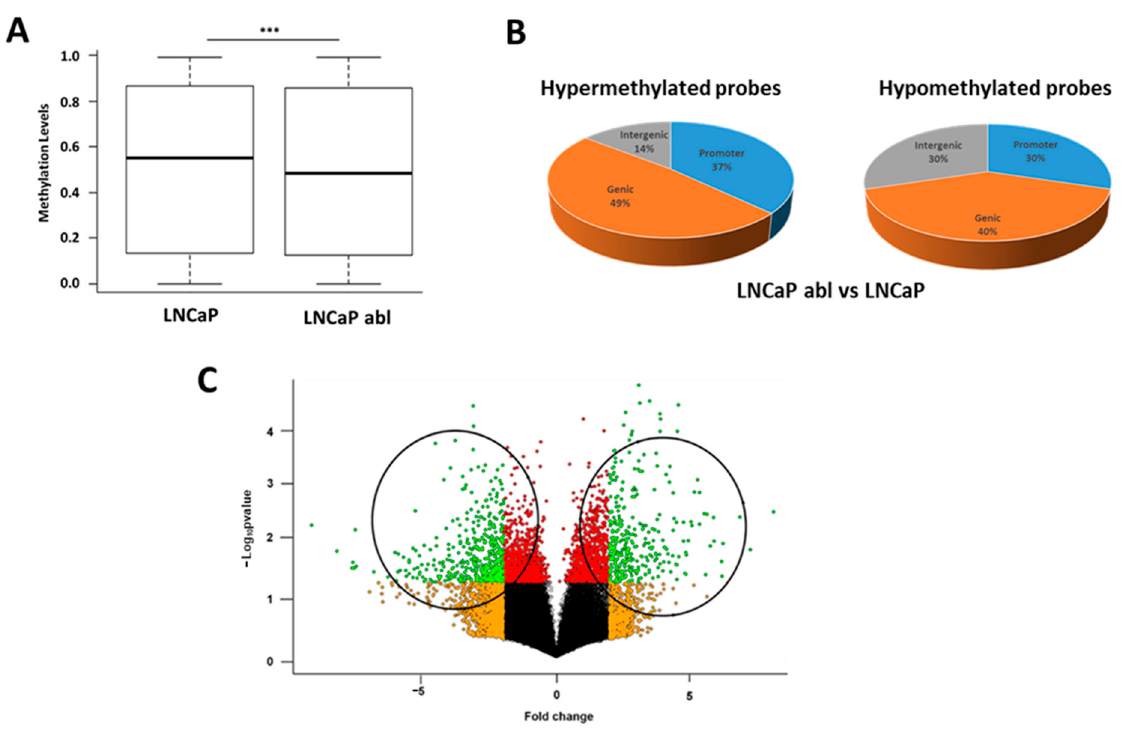
Figure 1. DNA methylation and expression profile of LNCaP and LNCaP abl cell lines. ( A ) Comparison of global DNA methylation levels of LNCaP and LNCaP abl cell lines. ( B ) Venn diagram showing genomic location of hypermethylated and hypomethylated probes in LNCaP abl cells compared to LNCaP cell line. ( C ) Volcano plot comparing gene expression profile between LNCaP and LNCaP abl cell lines. Each data-point represents a gene, with green dots representing downregulated (fold change < − 2 and p value < 0.05) and upregulated (fold change > 2 and p value < 0.05). *** p < 0.001.